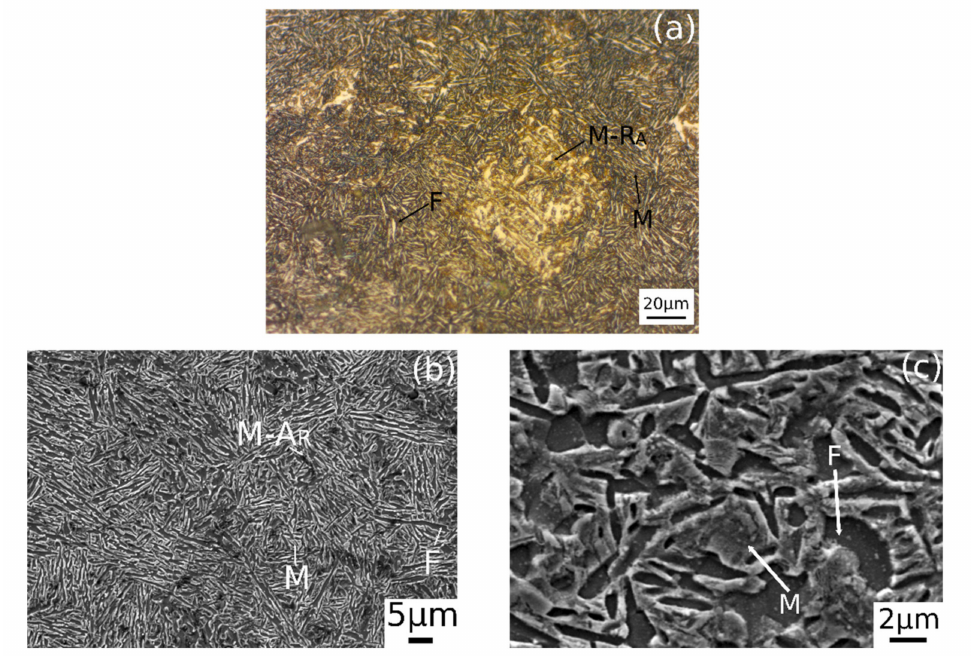
Figure 8. Microstructureofmaterialafteraustempering. ( a )Opticalmicrograph, ( b )and( c